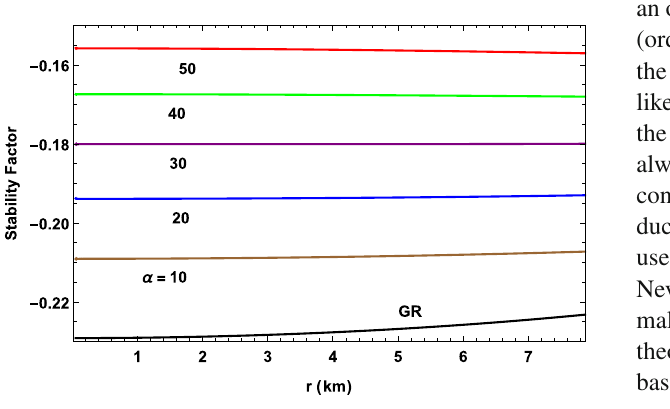
Fig. 8 Variationofadiabaticindexfor4U1538-52usingtheparameter provided in Table 1